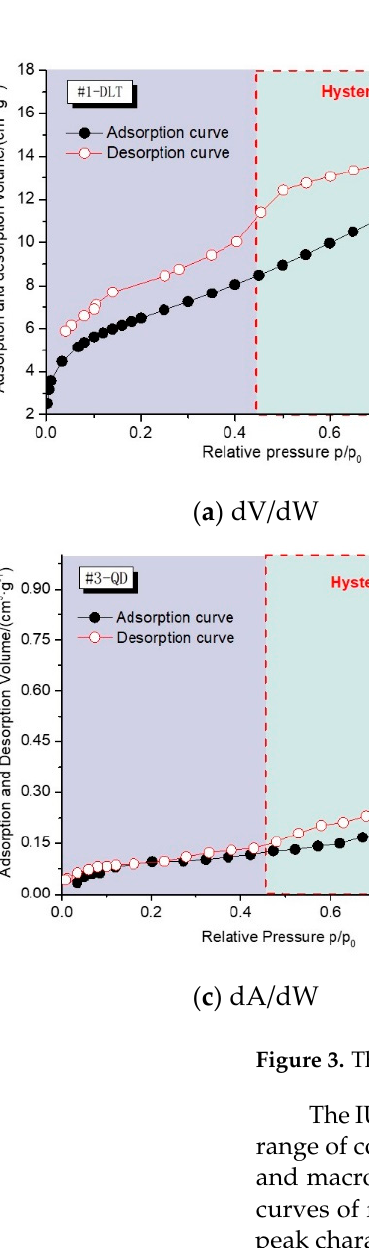
#1 − DLT > #4 − QC > #2 − XLZ > #3 − QD, which indicates that the #1 − DLT coal